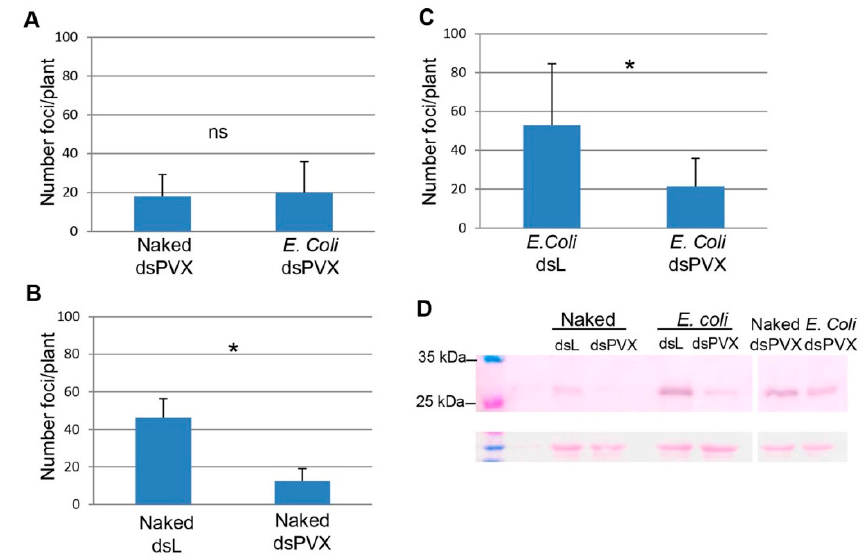
Figure 4. Effectiveness of encapsulated and naked dsPVX to induce local protection against PVX-GFP. The mean numbers ± standard deviations of infection foci on the inoculated leaves of plants that received different treatments are shown. ( A ) One half of the leaf was inoculated with PVX-GFP plus E. coli-encapsulated dsPVX (E. coli dsPVX) while the opposite half was inoculated with the virus and naked dsPVX. ( B ) One half of the leaf was inoculated with PVX-GFP plus naked dsPVX while the opposite half was inoculated with the virus and naked dsL. ( C ) One half of the leaf was inoculated with PVX-GFP plus E. coli-encapsulated dsPVX while the opposite half was inoculated with the virus and E. coli-encapsulated dsL (E. coli dsL). Asterisks indicate significant differences between treatments (Student’s t-test, p < 0.05). Ns: not significant. ( D ) Western blot analysis of plant extracts derived from inoculated leaves at 4 days post-inoculation, using antibodies against PVX CP. The upper right panel represents a longer time of exposure. The lower panel shows the Ponceau S-stained membrane after blotting, as a control of loading. *